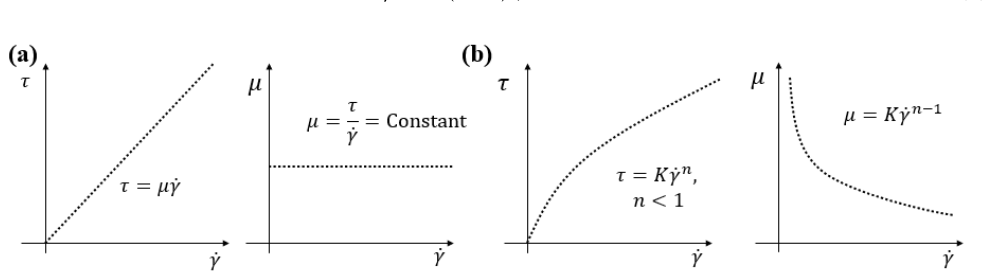
Figure 1. Schematic shear stress vs. shear rate and viscosity vs. shear rate for ( a ) Newtonian and ( b ) pseudo-plastic